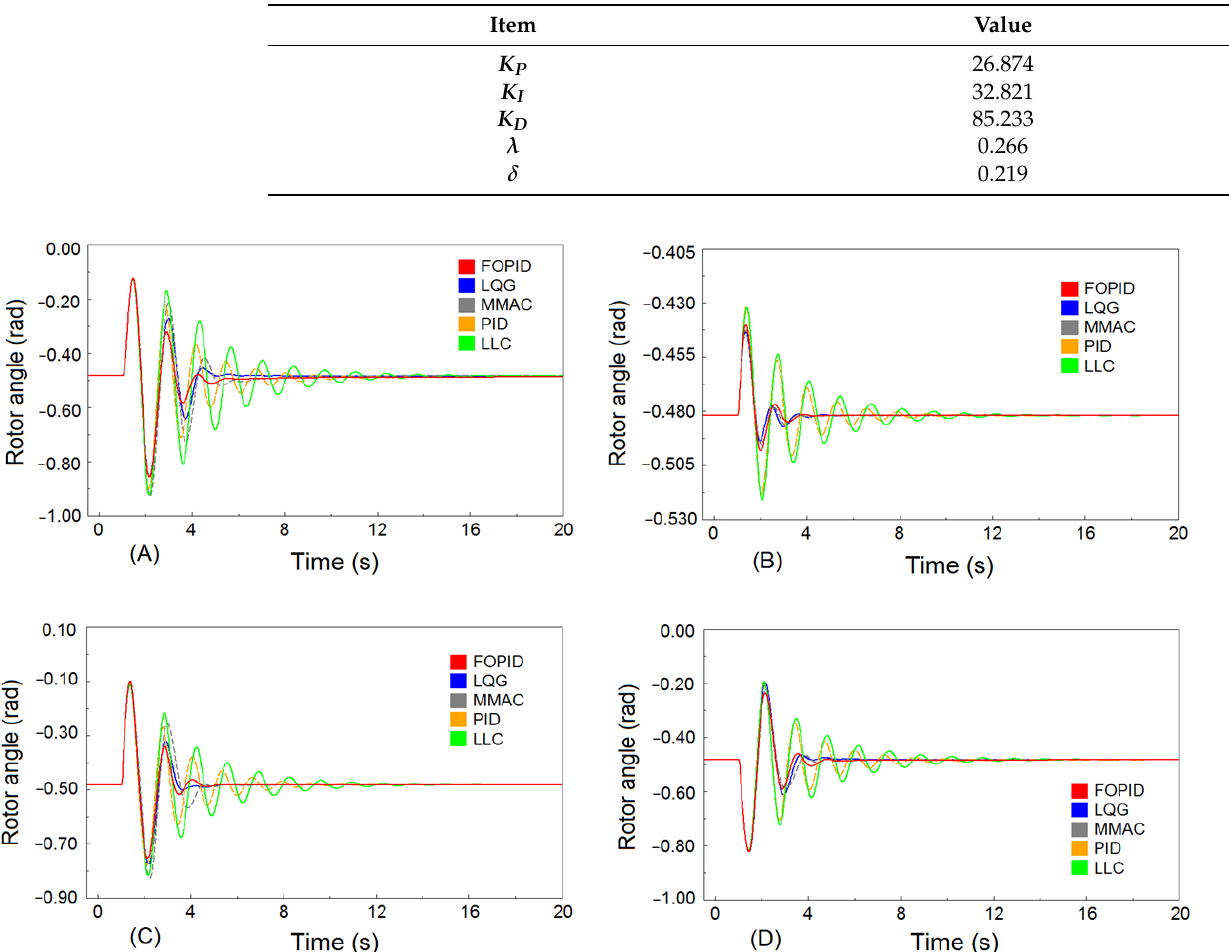
Table 9. Optimal values of the FOPID-PODC parameters for scenario 3.